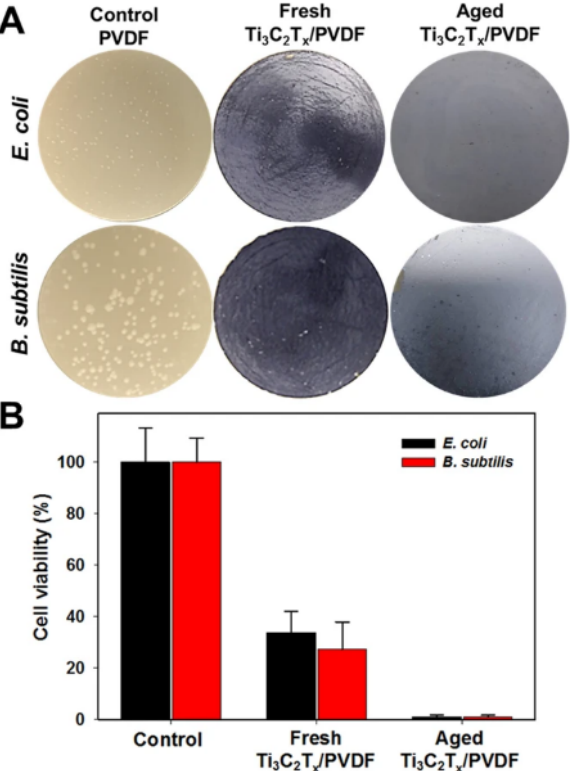
Figure 13. Ti 3 C 2 T x MXene has antibacterial action. ( A ) Photographs of E. coli and B. subtilis growth on unmodified PVDF (control), fresh and aged Ti 3 C 2 Tx MXene-coated PVDF membranes cultured for 24 h at 35 °C. ( B ) Cell viability measurements of E. coli and B. subtilis treated with Ti 3 C 2 T x , Fresh Ti 3 C 2 T x /PVDF and Aged Ti 3 C 2 T x /PVDF. The colony-forming count method was used to calculate survival rates. Reproduced with permission from [3].